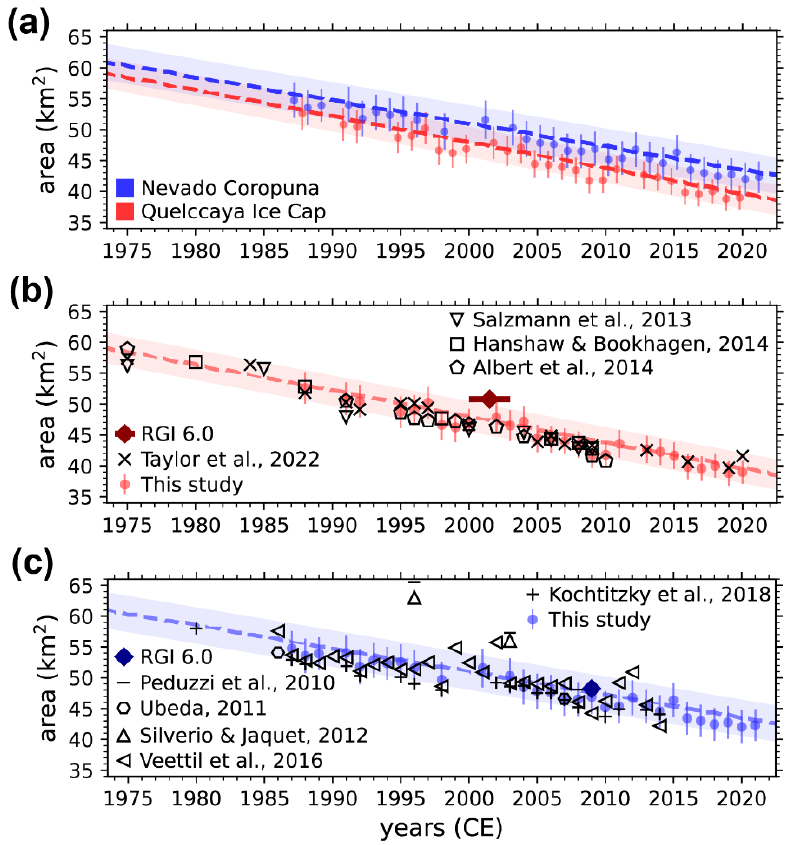
Figure 5. Evolution of the Quelccaya Ice Cap and the glaciers on Nevado Coropuna ( a ) compared to each other and compared to previously published studies for ( b ) Quelccaya and ( c ) Coropuna. Only the included years from Figures 2 and 3 are displayed, and the linear regression model for each ice mass is included. Shading around the linear regression models represents the average 2- σ uncertainties in area measurements.